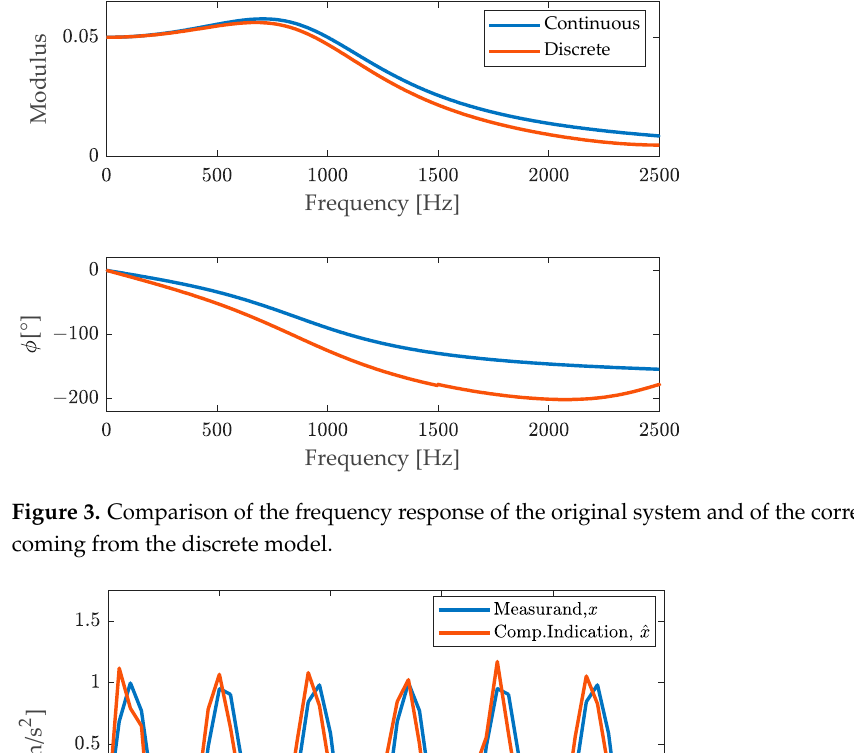
Figure 3. Comparison of the frequency response of the original system and of the corresponding one coming from the discrete model.